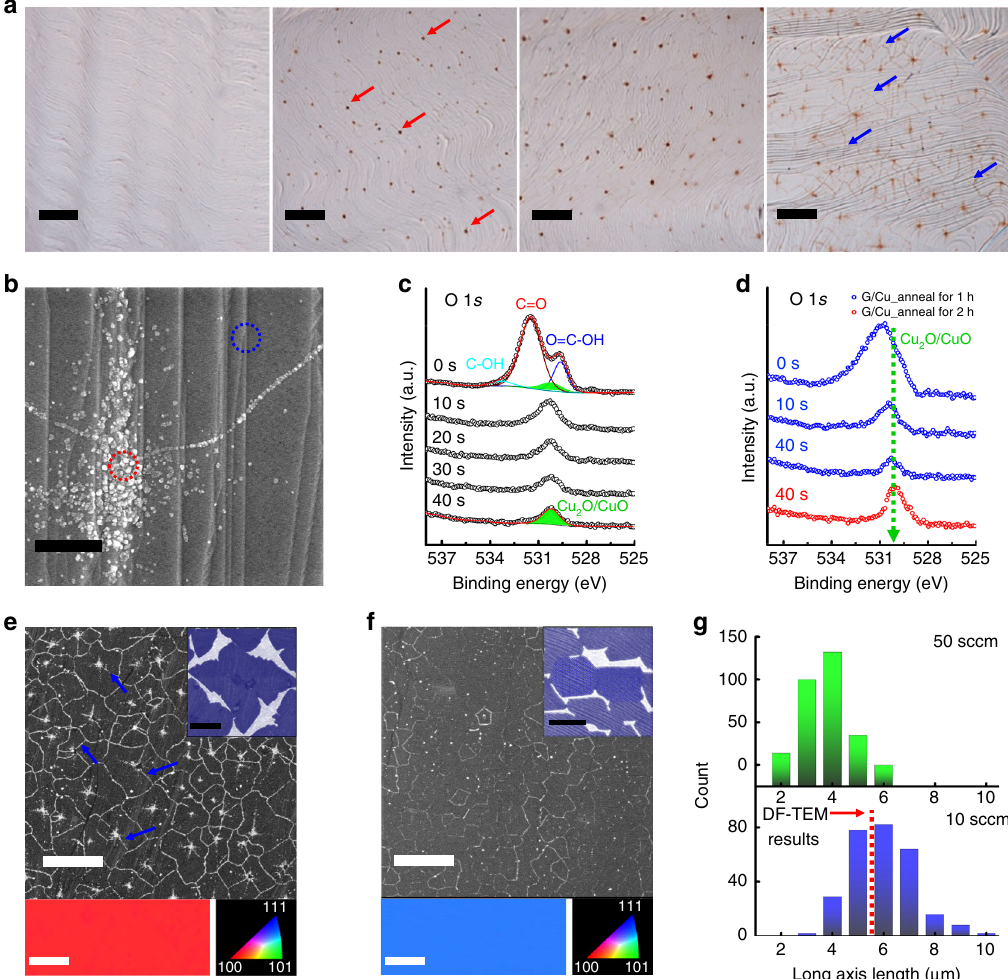
Fig. 1 Selective 0D and 1D oxidation fi ngerprints of fully-grown, air-annealed Gr/Cu samples at low temperatures. a OM images of the Gr/Cu sample after annealing at 200 °C for 30, 60, 90, or 120 min (from left to right) in air (scale bar = 10 µ m). b A representative SEM image of the Gr/Cu sample after annealing at ~200 °C for 120 min in air (scale bar = 0.5 µ m). c Depth-pro fi ling HR-XPS O 1 s line scans of the Gr/Cu sample after annealing at ~200 °C for 120 min in air, depending on the sputtering time. Curve fi ttings of O 1- s spectra were performed using a Gaussian – Lorentzian peak shape after Shirley background correction. d Comparison between HR-XPS O 1- s peaks of the Gr/Cu samples annealed at ~200 °C for 60 and 120 min in air, depending on the sputtering times. Representative SEM and corresponding EBSD images of a continuous Gr fi lm grown on the grains of e Cu(001) and f Cu(111); the image was collected after an air oxidation process at ~200 °C for 60 min (scale bar = 10 µ m). The insets in e and f show the SEM images of partially grown